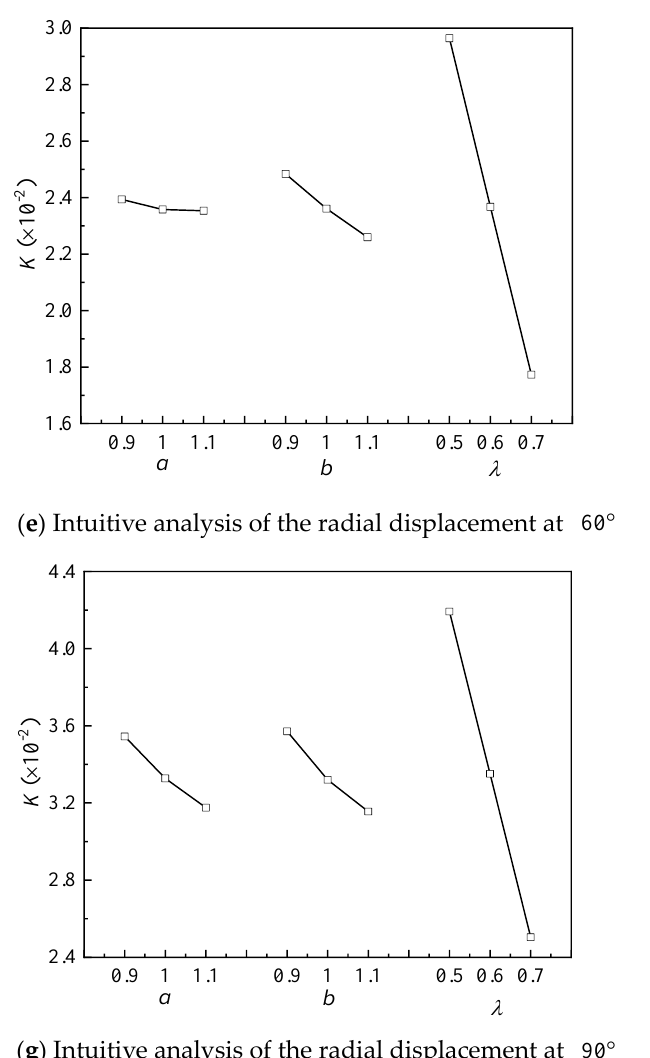
Figure 10. Intuitive analysis of influence factors of the radial displacement.